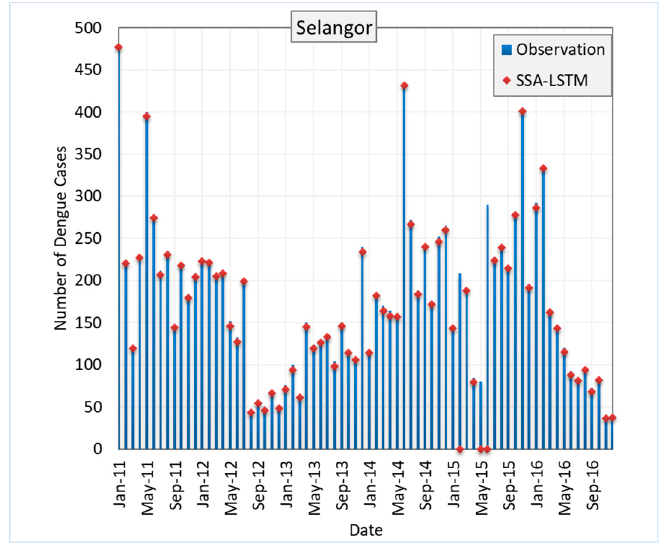
Figure 8. Performance of SSA-LSTM model for dengue fever prediction in five Malaysian states, measured by RMSE.